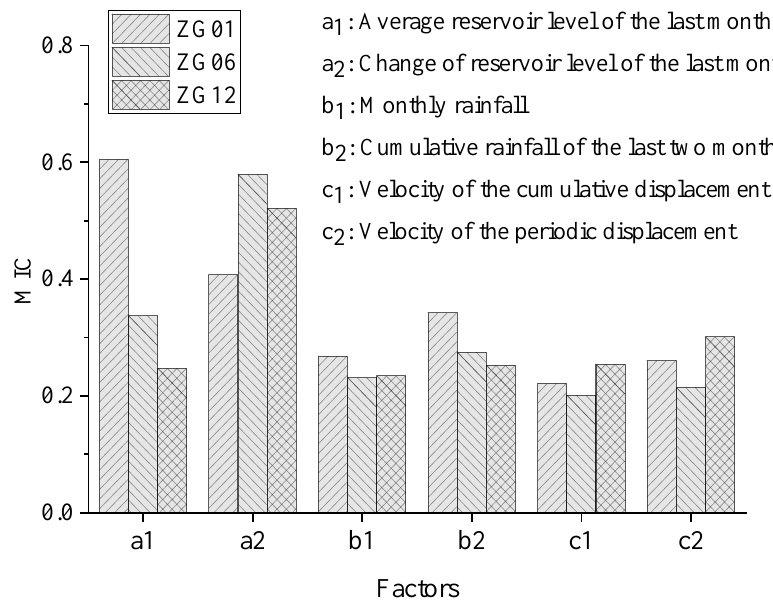
Figure 7. The MIC values between the periodic displacement and candidate factors.